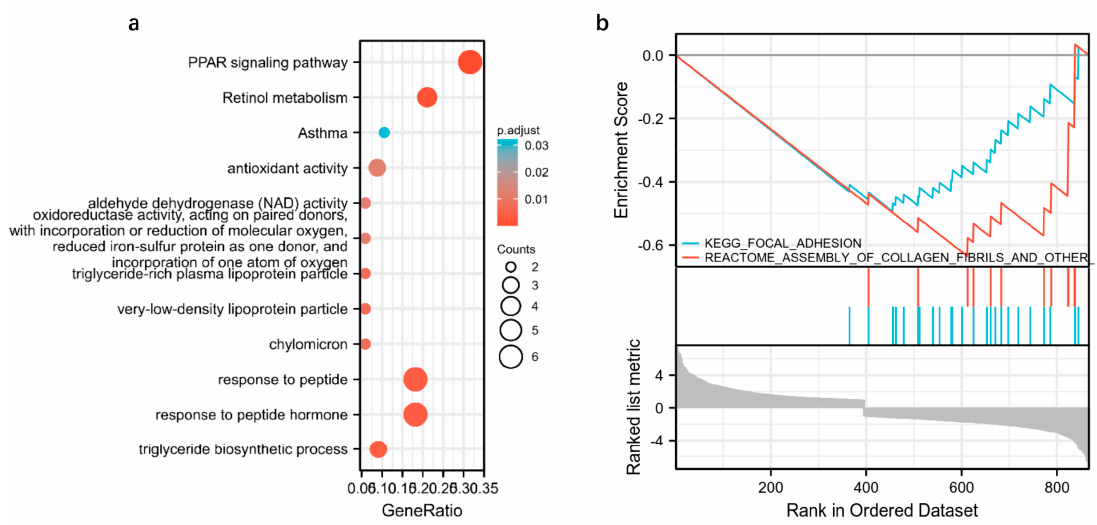
Figure 4. Gene set enrichment analysis (GSEA)-based analysis. ( a ) Pathways enriched in the 34 over- lapping genes. ( b ) Results of GSEA.